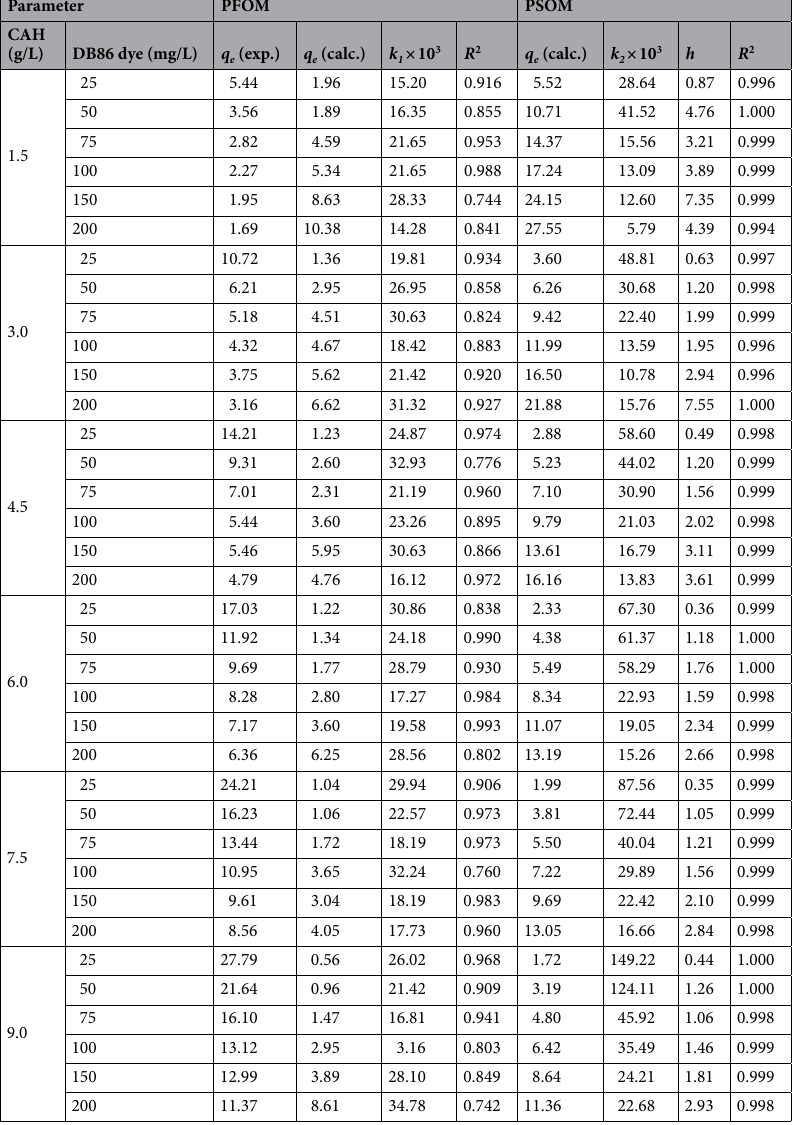
Table 3. PFOM and PSOM results of AB86 dye absorption [ C 0 (25–200 mg/L) by CAH doses (1.5–9.0 g/L), and Temp. (25 ± 2